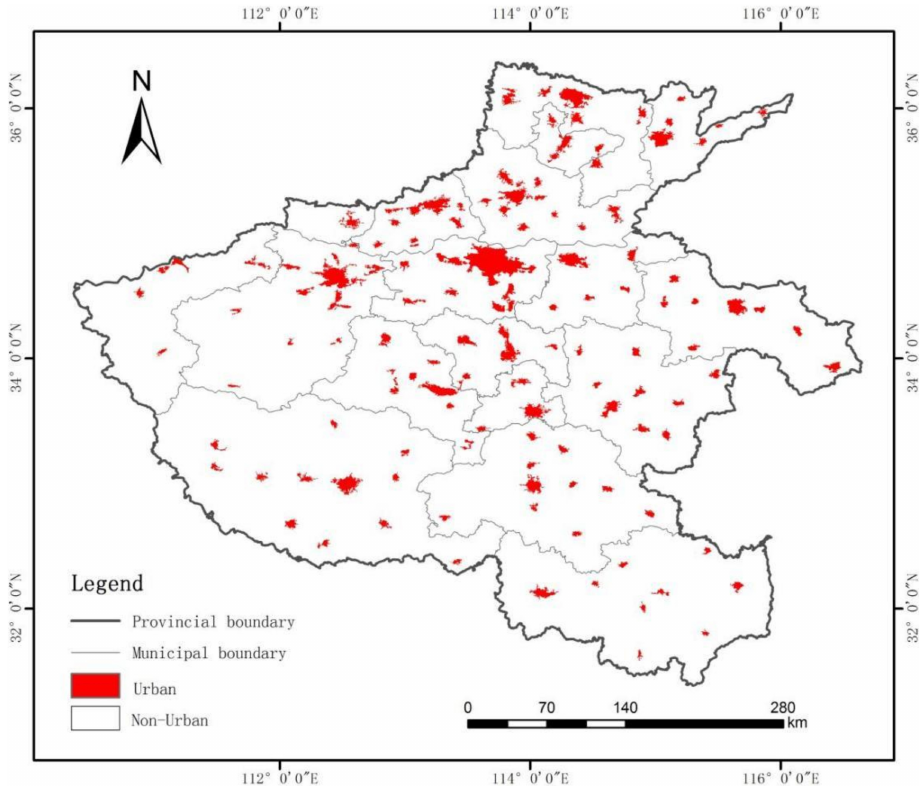
Figure 4. Results of urban boundary delimitation in Henan